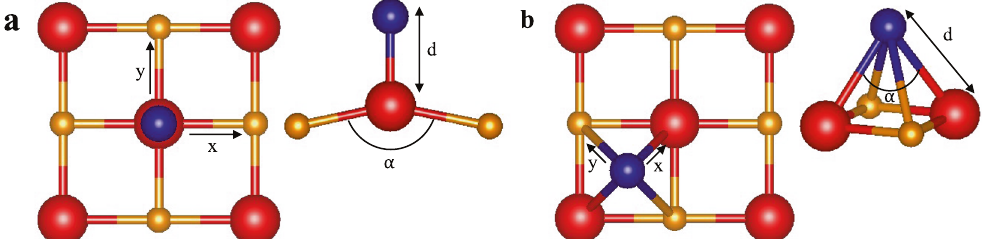
Fig. 3 Geometry of adatoms on MgO, NaF and NaCl. Top and side views of ( a ) adatom stacked on top of anion and ( b ) adatom in the bridge position. The adatom is represented by a blue sphere, the anion by a red sphere, and the cation by an orange sphere. The de fi nition of the distance d between the adatom and anion and the cation – anion – cation bond angle α is also illustrated.